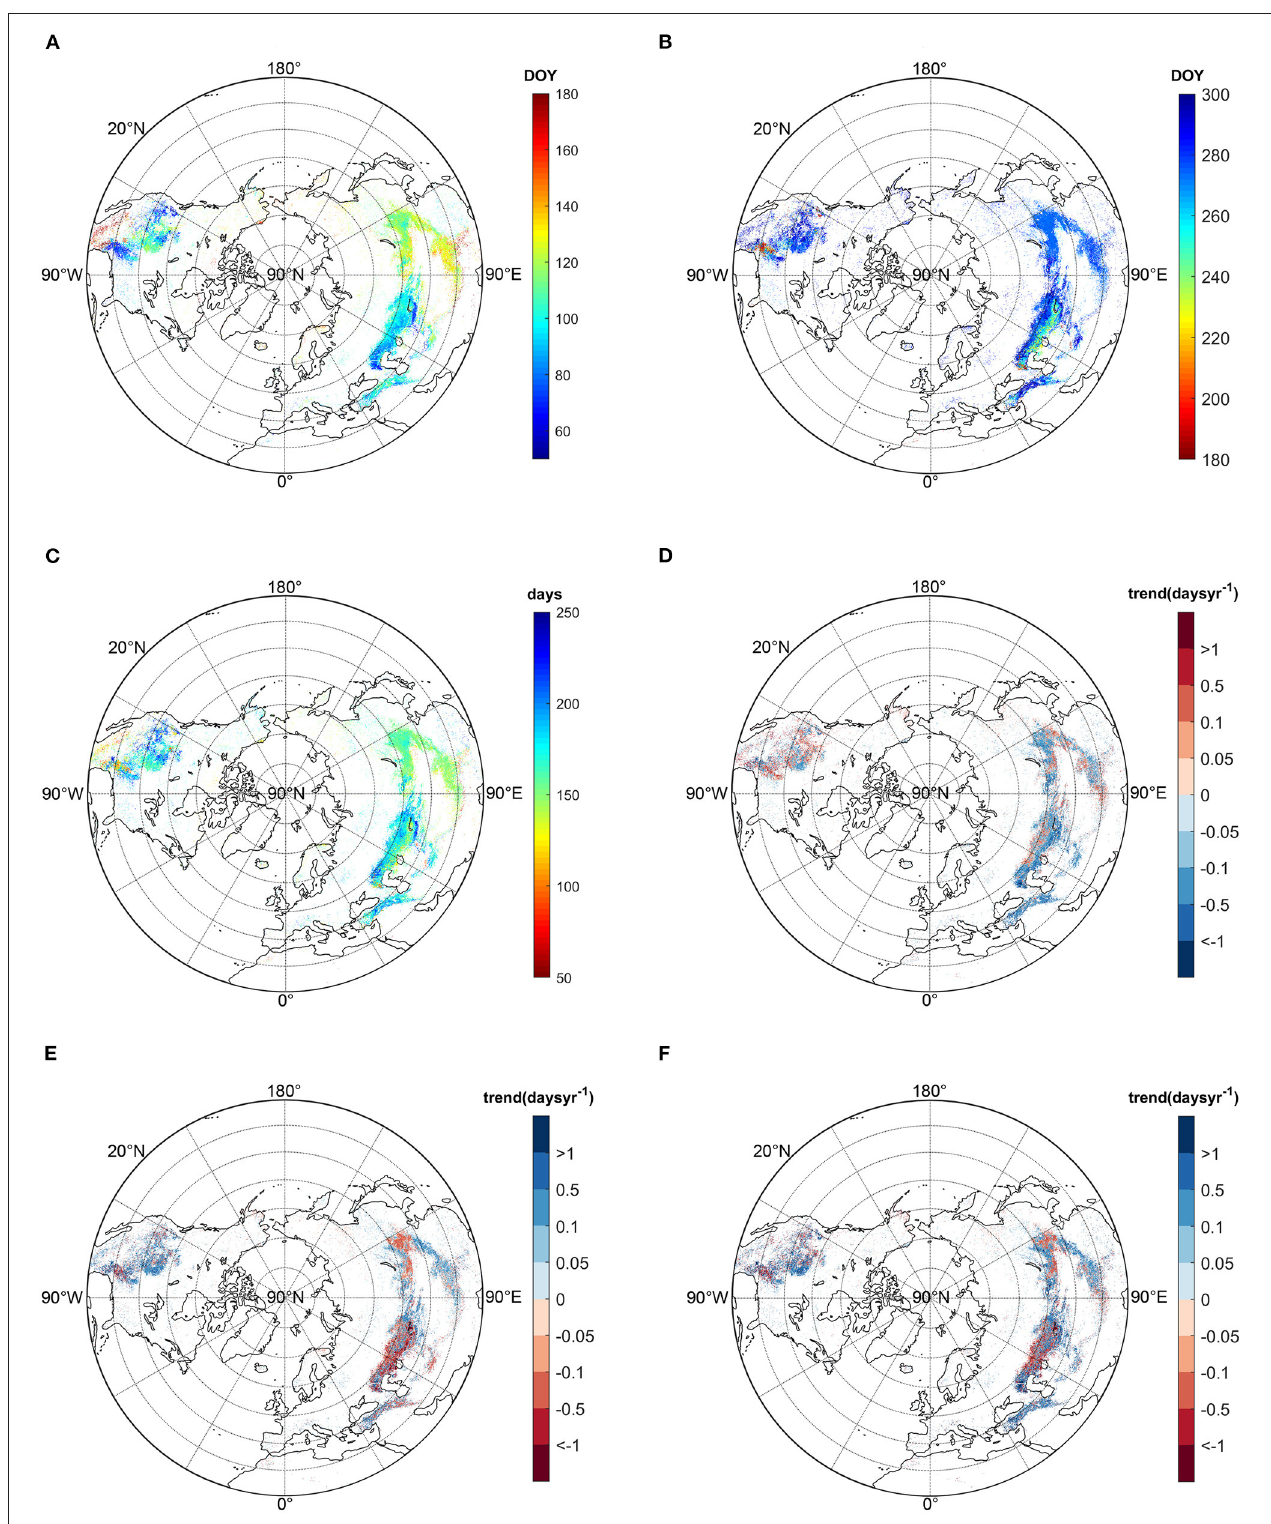
FIGURE 1 | Annual mean SOS (A) , EOS (B) , GSL (C) , and trends of SOS (D) , EOS (E) , and GSL (F) during the period of 1982–2011.